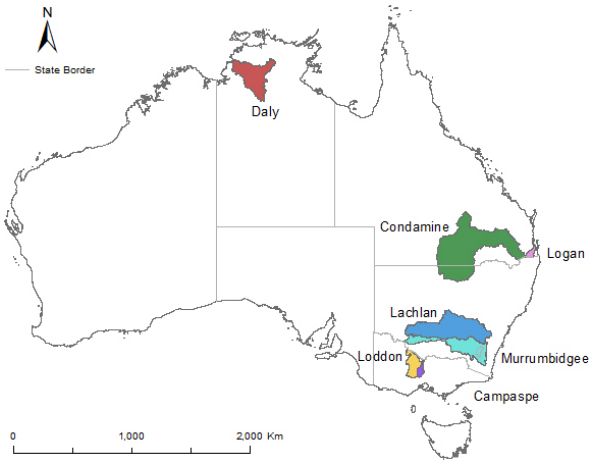
Fig. 1. Location map for the catchments used in this